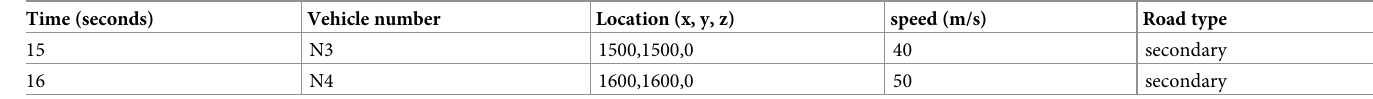
Table 2. Example row from TLILS passing location table [2].